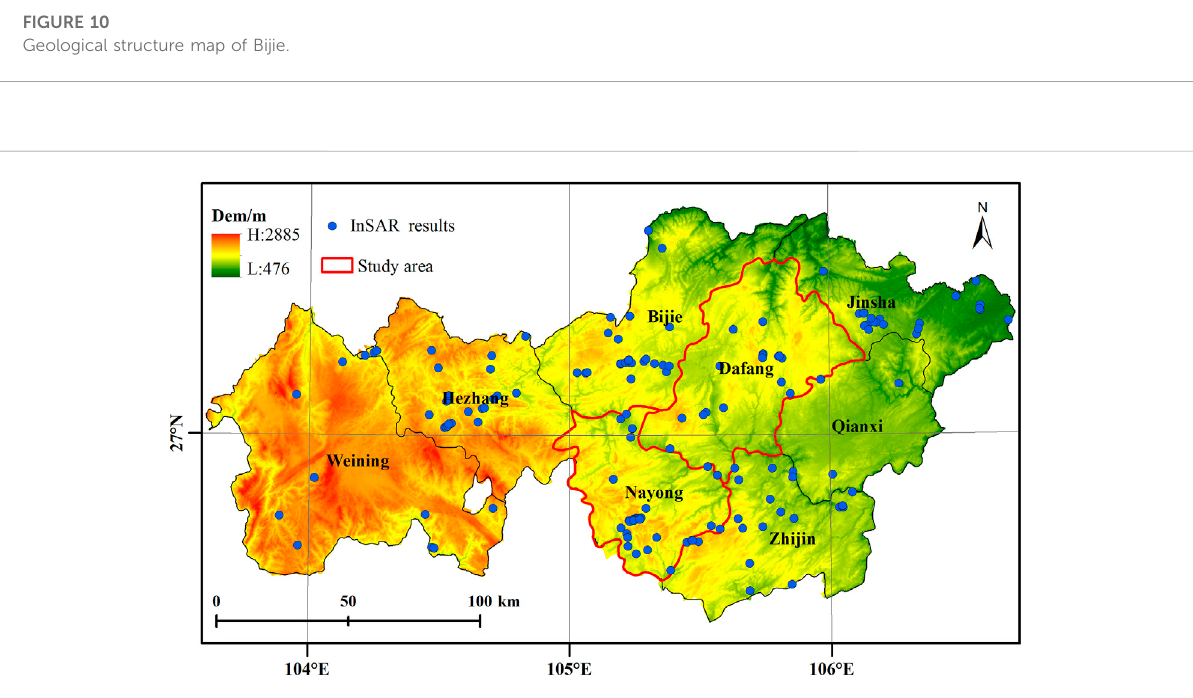
FIGURE 11 DInSAR potential landslide